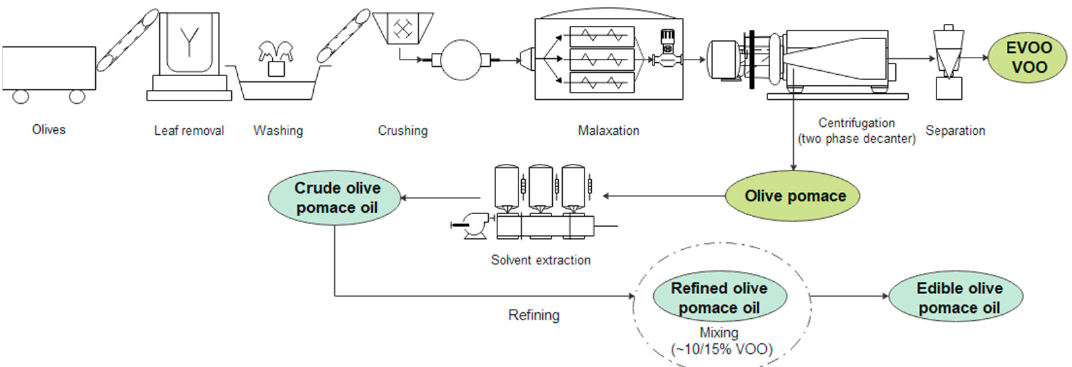
Figure 1. Olive oil and olive pomace oil production process.